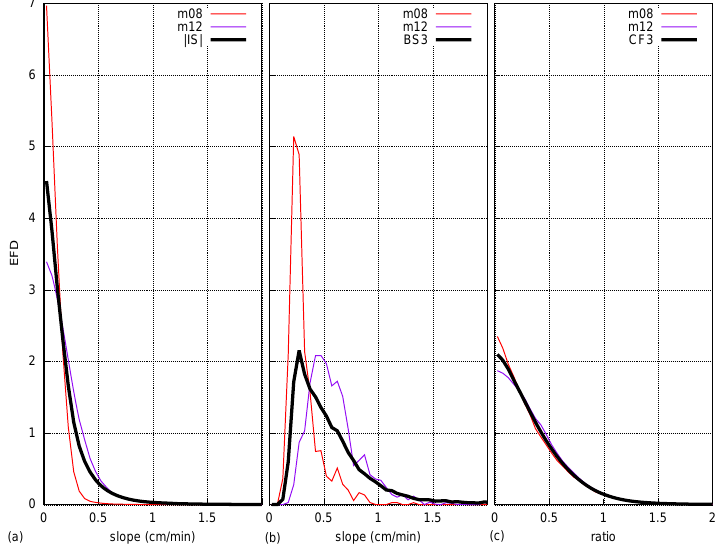
Fig. 6. Empirical frequency distributions computed for the functions (a) | IS | , (b) BS3 and (c) CF3 of configuration A3C2 for the Catania station. Here the EFD for the whole interval is shown together with the EFDs for the months of December and